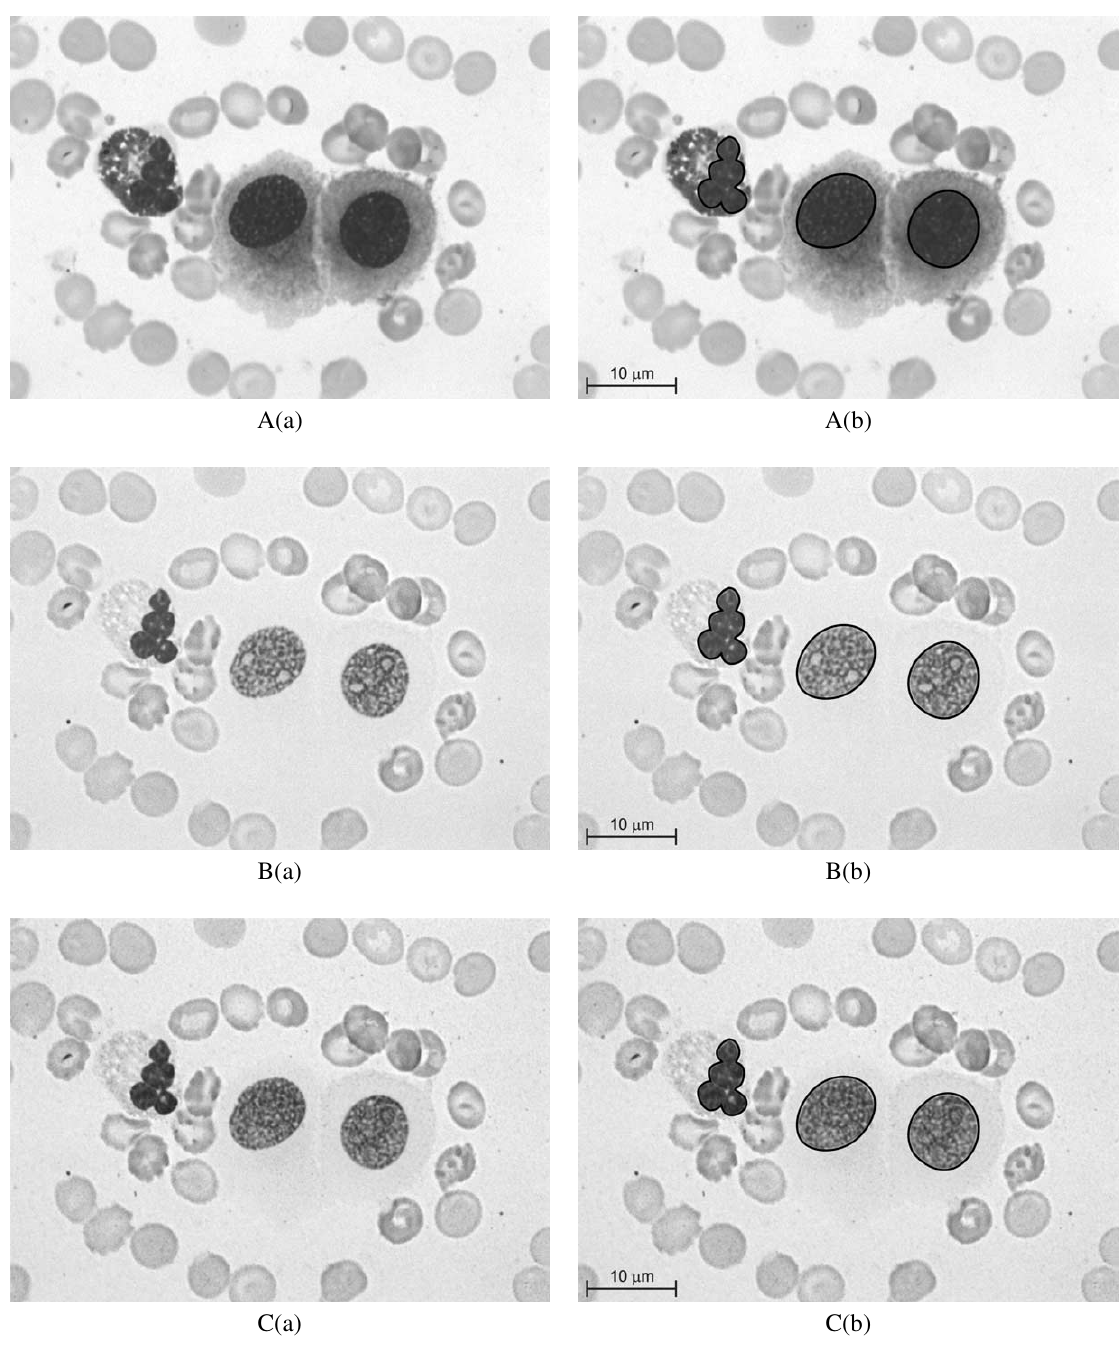
Fig. 1. Multimodal cell analysis on two identical malignant epithelial mesothelioma cells and one neutrophilic granulocyte sequentially stained first according to May–Grünwald–Giemsa (MGG) for subjective evaluation (figure series A), secondly according to Feulgen for DNA-image cytometry (figure series B) and thirdly with silver nitrate for AgNOR-analysis (figure series C). The cells were repeatedly automatically relocated using a Leica DMLA microscope and a 63 × objective, n.a. 1.25, controlled by a self-developed software for precise cellular relocation (a) after conventional staining only, (b) after nuclear segmentation, (c) after nuclear segmentation and AgNOR-detection: overlay of AgNOR-masks on MGG- and Feulgen-images, (d) after IOD-measurement and AgNOR counting with DNA content in c-units and number of single AgNOR’s and -clusters. An animated sequence of these images can be seen at our website: